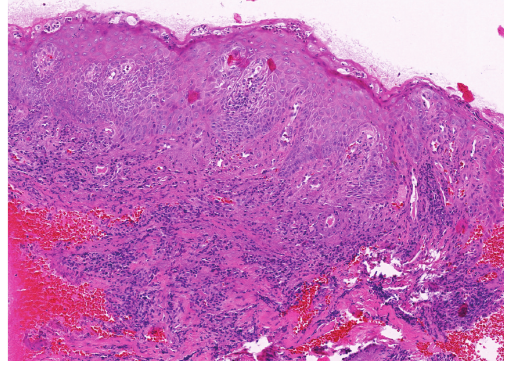
Figure 3: Inflammation within the epithelium and the lamina propria (H&E stain, 10x).